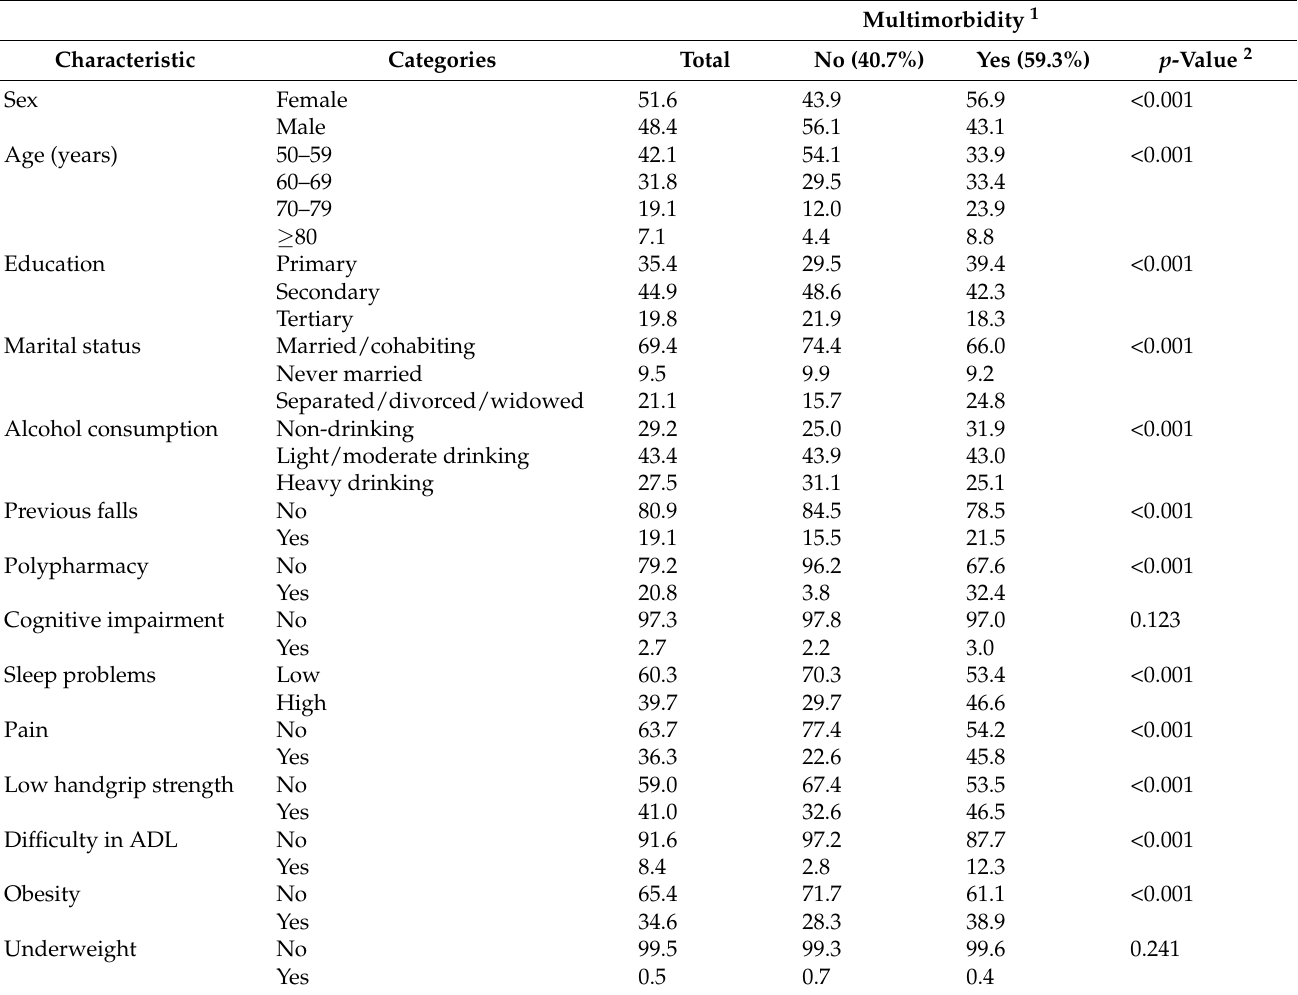
Table 1. Sample characteristics (overall and by multimorbidity status).